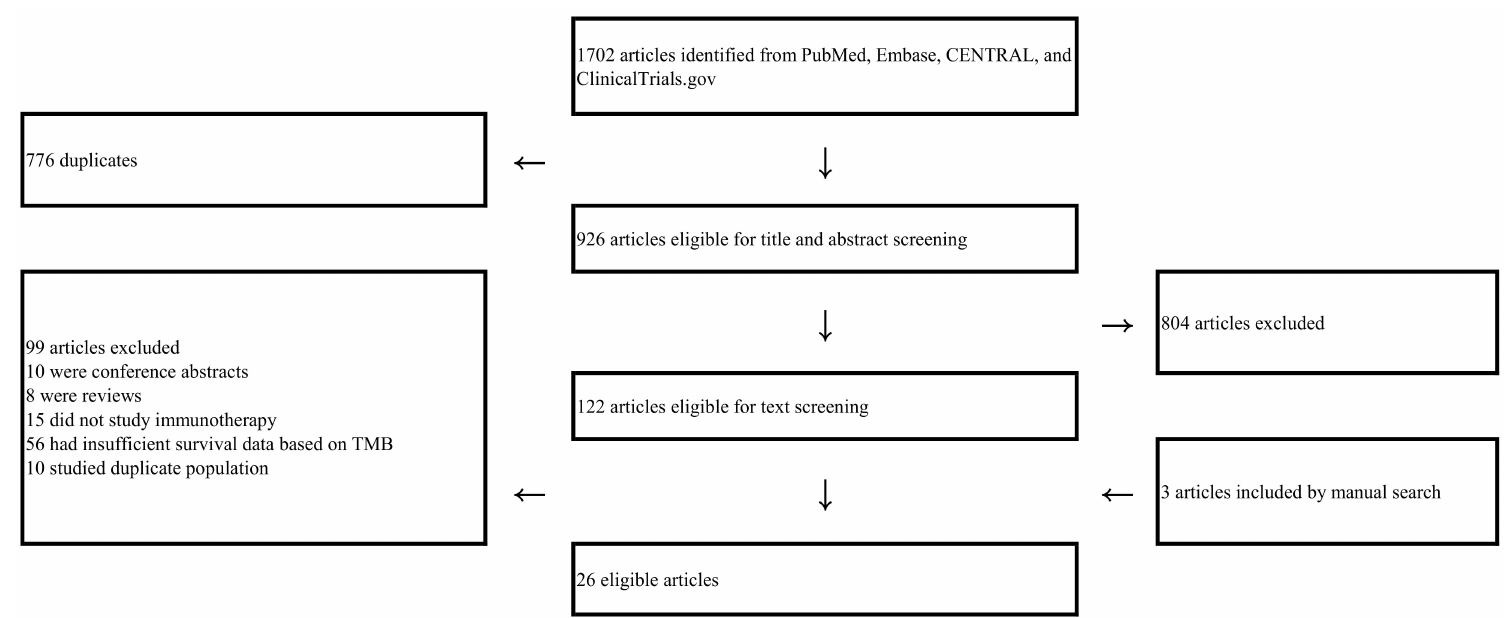
Figure 1. Flow of the literature